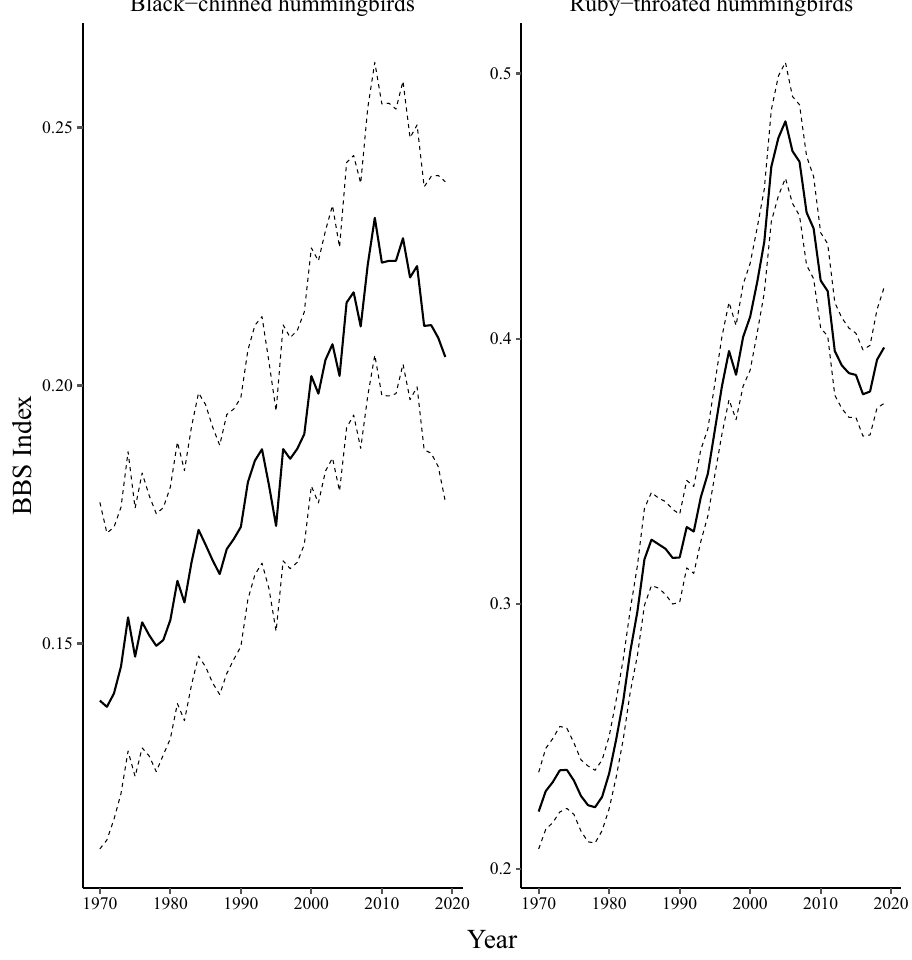
Figure 3. Breeding Bird Survey indices for North American hummingbirds in the Archilochus genus from 1970 to 2019. The species of Archilochus genus represented here are black-chinned hummingbirds ( Archilochus alexandri ) and ruby-throated hummingbirds ( Archilochus colubris ). Dashed lines represent upper and lower bounds of the 90%